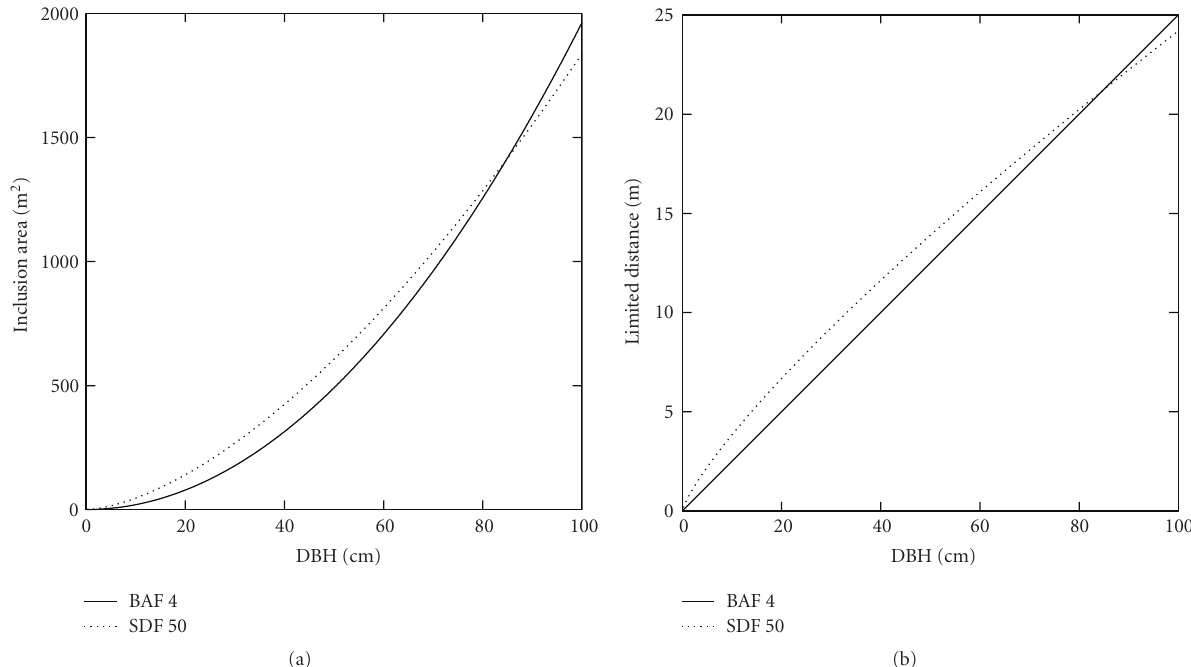
Table 1: Critical distances and required “push” for sampling with a stand density factor (SDF) of 50, using a basal area factor (BAF) 4m 2 /ha prism. When the “push” is shown as negative, the prism must be pulled back across the point. DBH, cm